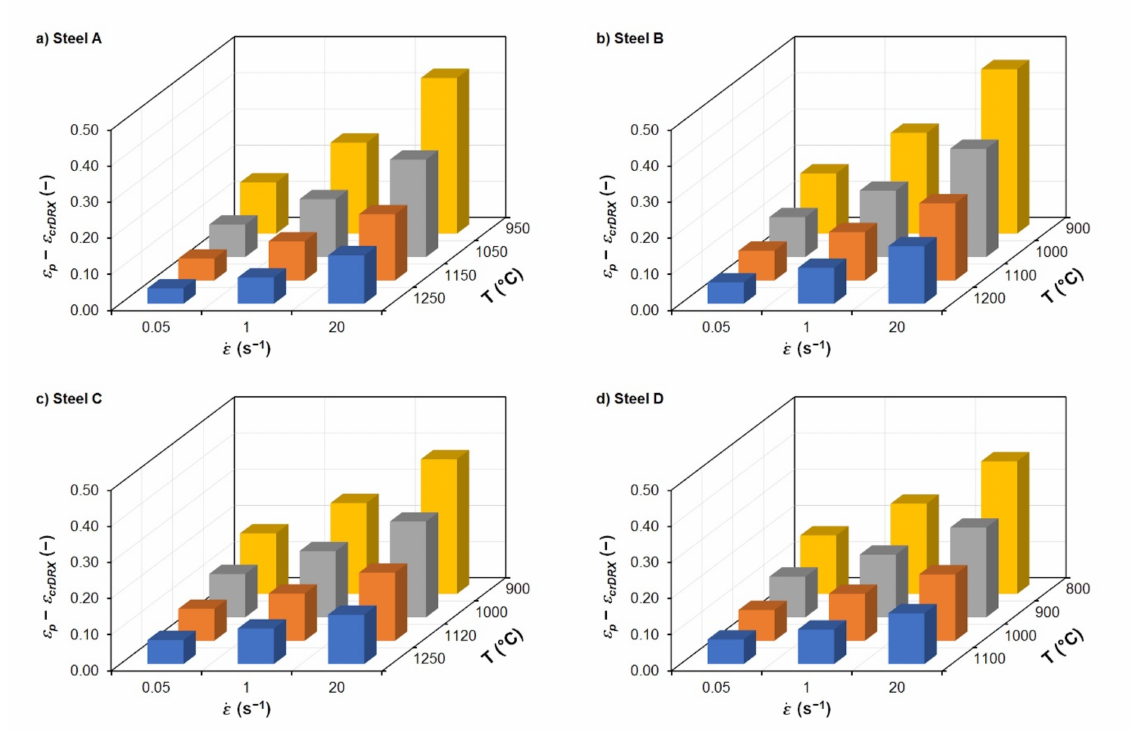
Figure 14. Graphical comparison of the difference between the peak strain ε p and the critical strain ε crDRX of the investigated steels: ( a ) steel A; ( b ) steel B; ( c ) steel C; ( d ) steel